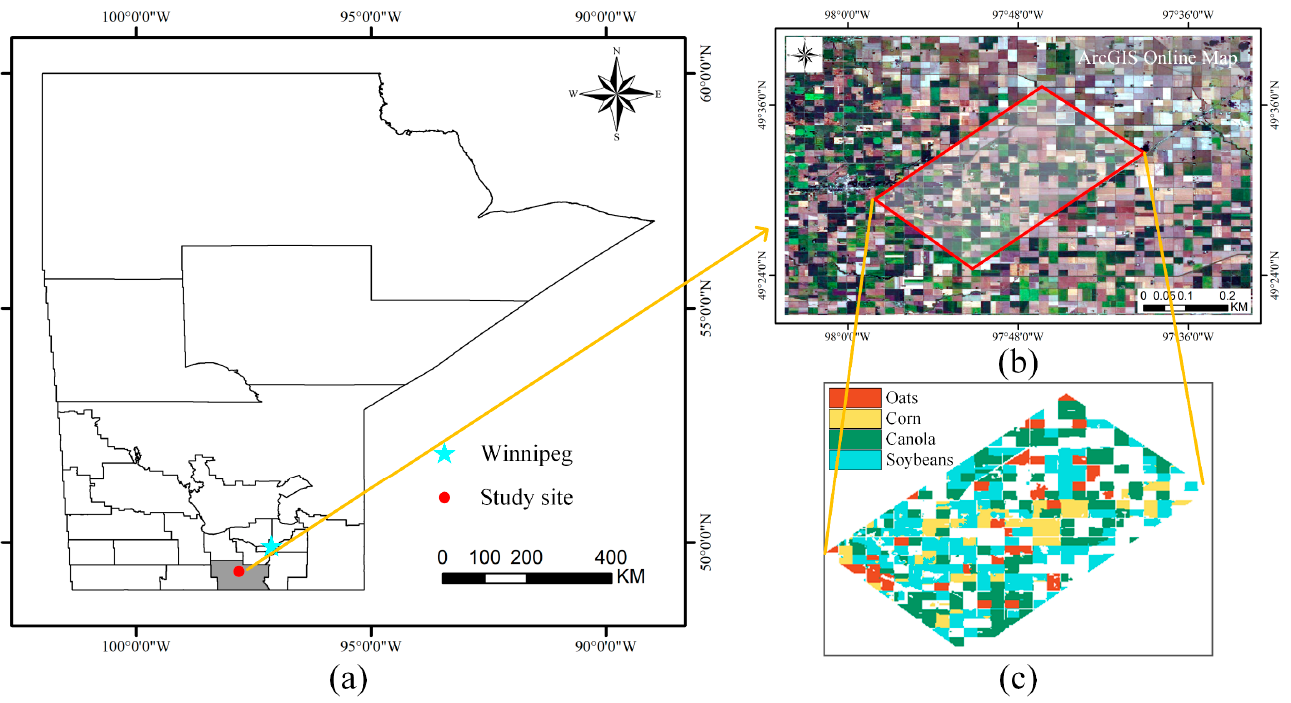
Figure 1. Overview of the study area: ( a ) location of the study area; ( b ) overview of the study area in ArcGIS Online Map; ( c ) reference map of crop distribution.